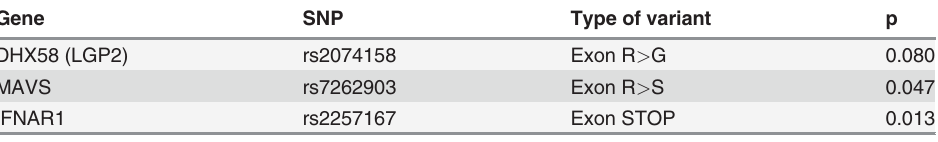
Table 4. Association results from phenotype cluster / severity analysis, using Kendall ’ s